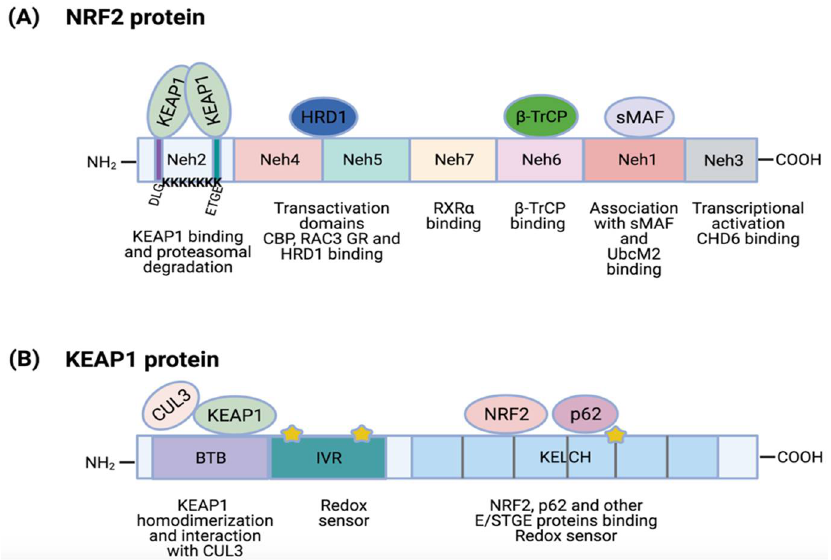
Figure 2. NRF2 and KEAP1 protein structures. ( A ) NRF2 contains 7 highly conserved domains called Neh domains. Neh1 is required for complex formation with transcription factor sMAF, DNA binding and for binding to UbcM2. Neh2 contains ETGE and DLG sequences that are required for KEAP1 binding and 7 ubiquitin-lysine residues for targeting NRF2 for proteasomal degradation. Neh3 is needed for transcriptional activation (CHD6 binding). Neh4 and Neh5 are transactivation domains that bind activators (CBP, RAC3) or repressors (GR, HRD1). Neh6 regulates NRF2 stability by binding to β-TrCP. Finally, Neh7 can interact with RXRα, an NRF2 repressor. ( B ) KEAP1 protein contains 5 conserved regions: N-terminal region, BTB, IVR region, DGR domain and C-terminal region; DGR and C-terminal regions form a Kelch motif. The BTB domain facilitates KEAP1 homodimerization and CUL3 binding. The IVR region possesses a cysteine-rich domain that acts as a direct redox sensor. DGR/Kelch regions contains 6 repeats of a Kelch motif that mediate their interaction with NRF2 and other proteins with E/STGE conserved motifs, such as p62. This region also contains additional cysteine residues for stress sensing. Stars represent several cysteine residues located in IVR and Kelch domains.